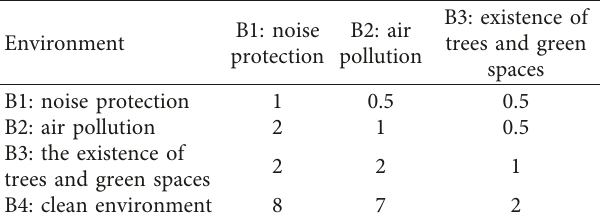
Table 4: Matrix of environment